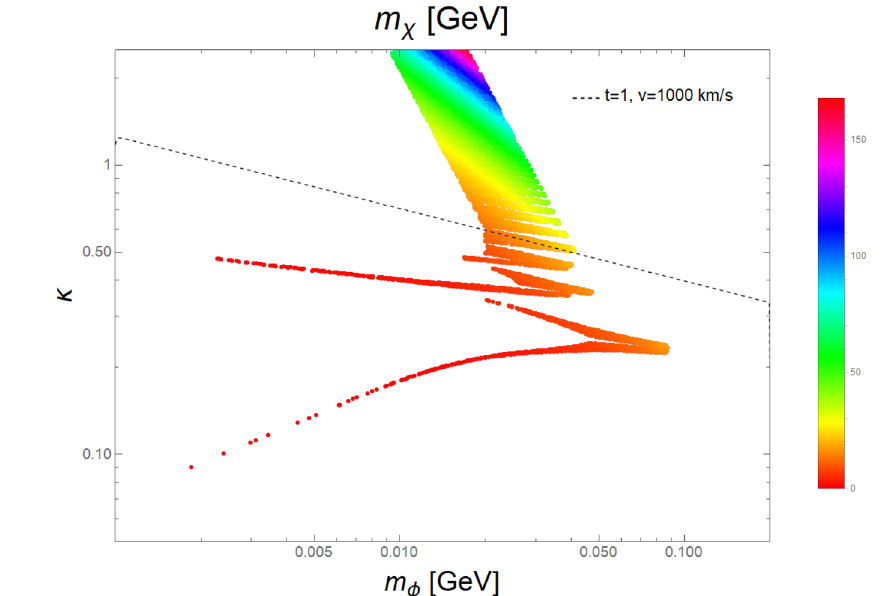
Figure 3 . Dots represent the region, where the small scale structure problem can be addressed, according to analytic formulas σ Comb /m χ . The value of m χ of each selected point is fixed to make V Ω h 2 = 0 . 12 based on eq. (3.12). The dashed line satisfies t = 1 when v = 1000 km/s.